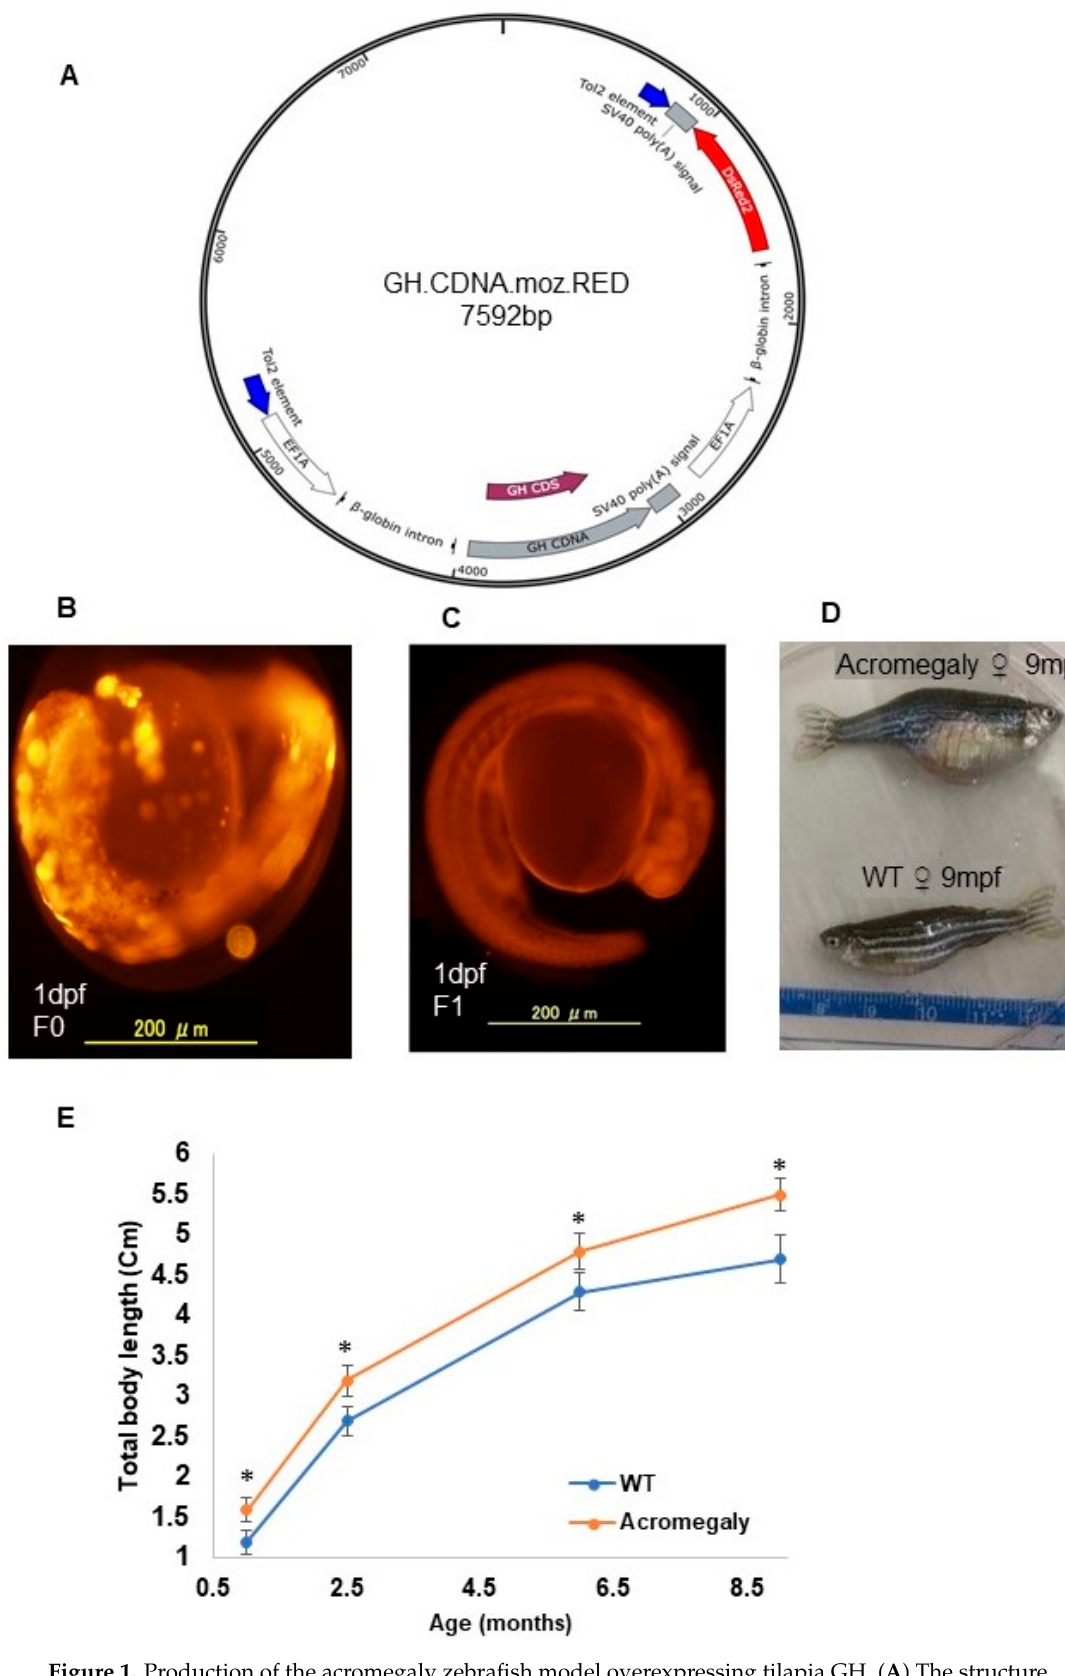
Figure 1. Production of the acromegaly zebrafish model overexpressing tilapia GH. ( A ) The structure of the GH-CDNA-moz-RED construct used to produce acromegaly zebrafish. The blue arrows indicate Tol2 transposable element. EF1A promoters drive expression of Tilapia GH cDNA and